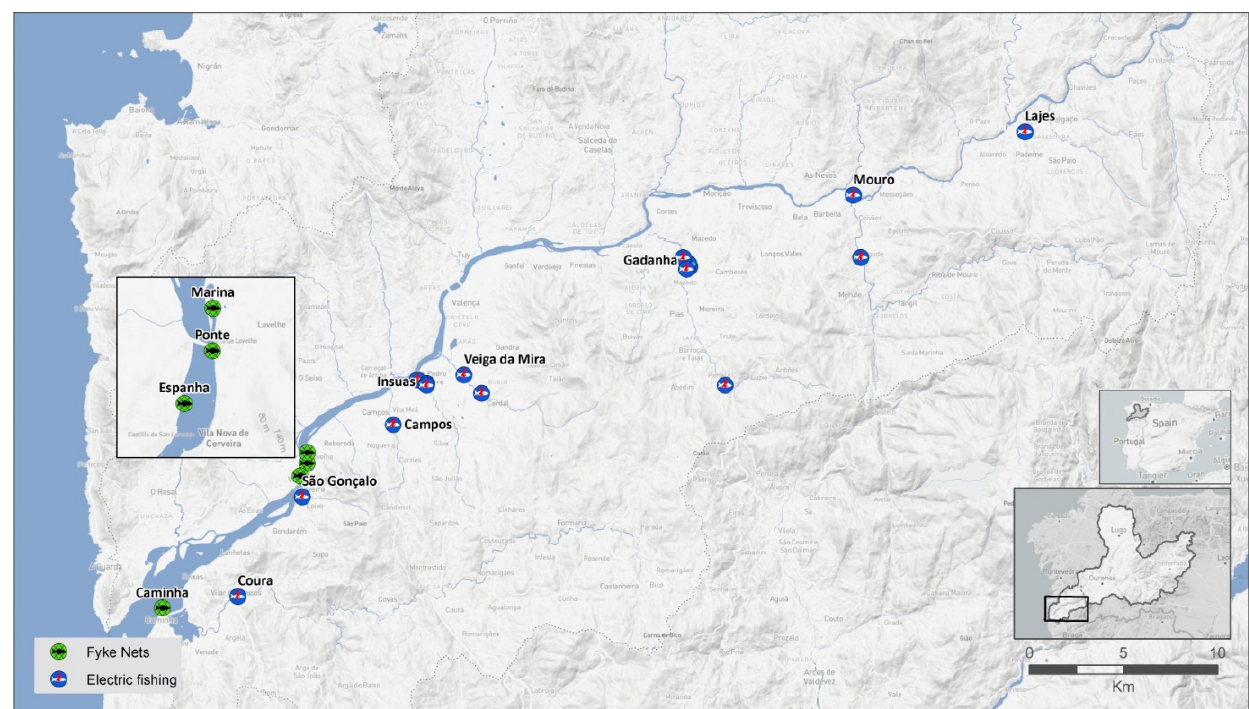
Figure 1. Map showing the sampling locations of the Anguilla anguilla individuals collected from November 2017 to October 2020 in the Minho River basin. Green dots denote the estuary sampling locations, and blue dots show the tributaries’ sampling locations.